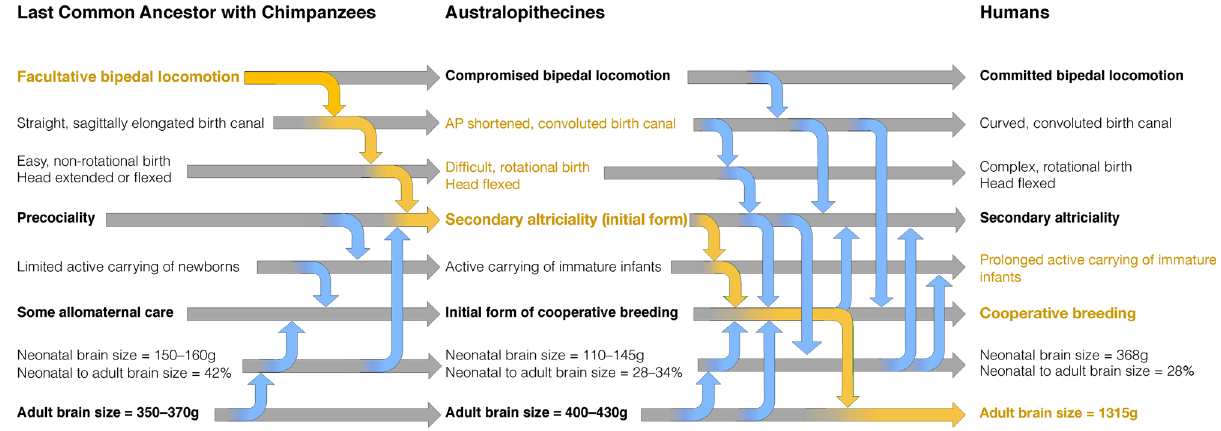
Fig. 5 Obstetrically relevant evolutionary changes during hominin evolution and their interrelationship with locomotion and encephalization. Adaptations to bipedal locomotion in early hominins are proposed to be at the origin of an evolutionary cascade (yellow arrows and text) that led to an antero-posteriorly (AP) shortened and convoluted birth canal. As a solution to this increased birth complexity, australopithecines gave birth to secondary altricial newborns with relatively small brain sizes. These neurologically immature newborns had to be carried by family members, thereby necessitating the evolution of cooperative breeding, which represented an exaptation for brain size enlargement in the genus Homo . Bold font: main characteristics; gray arrows: evolutionary changes; blue arrows: in fl uencing